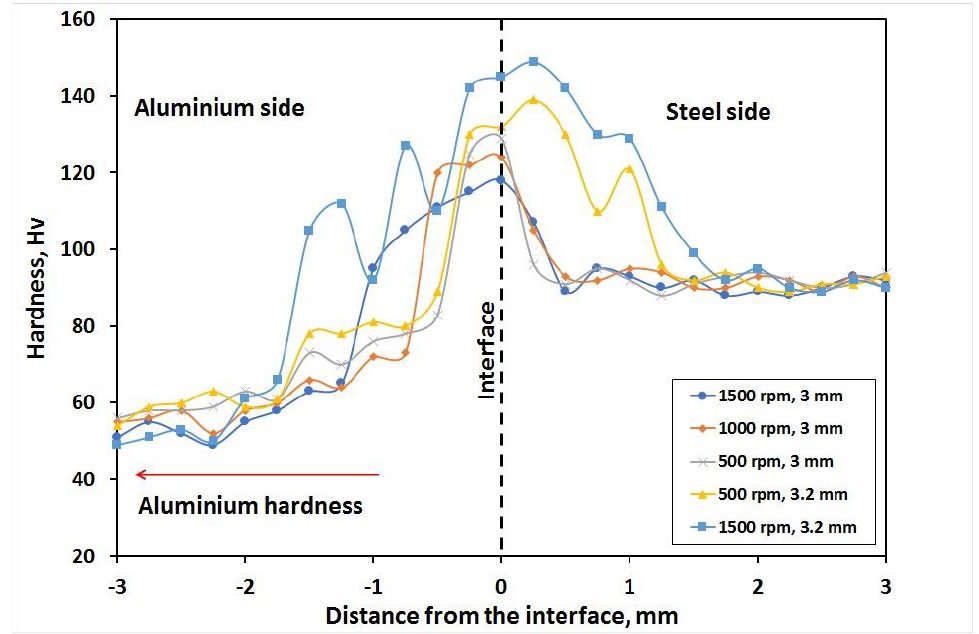
Figure 15. Hardness distribution of the aluminum/steel interface produced with different FSP rotation speeds and pin lengths.